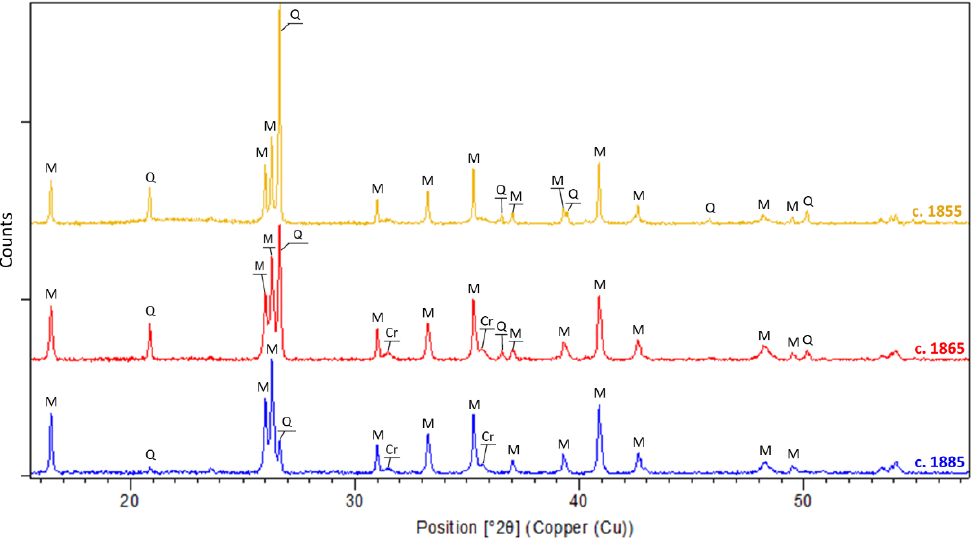
Figure 6. Diffractograms of a representative sample of porcelain bodies for each identified production period; Q: quartz, Cr: cristobalite, M: mullite.